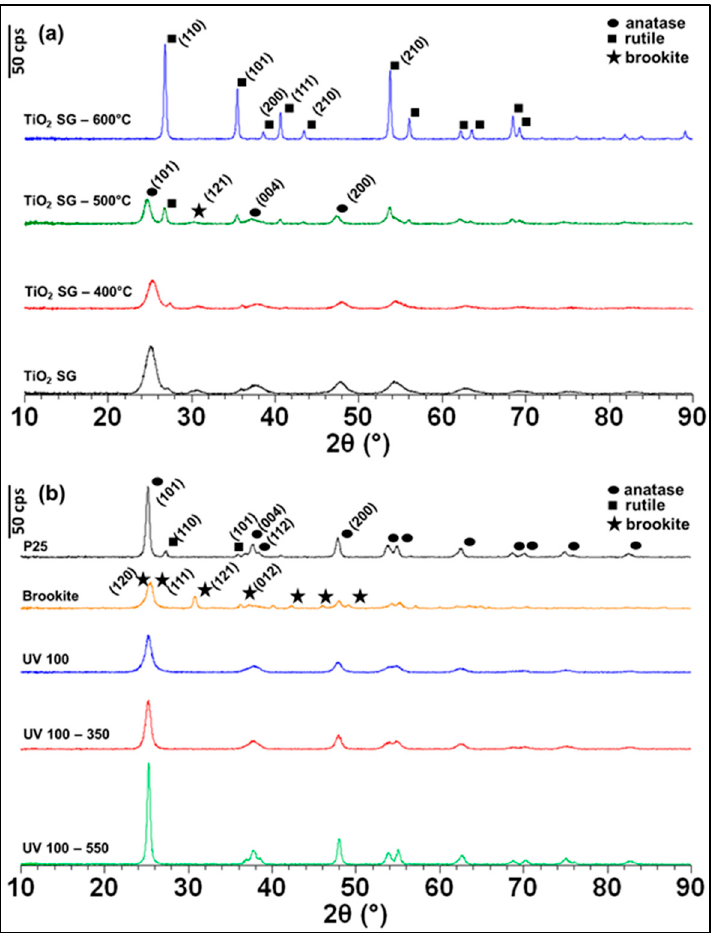
Figure 1. XRD pattern of ( a ) TiO 2 SG-X and ( b ) TiO 2 brookite and TiO 2 P25, and TiO 2 UV100-X commercial-based samples. Table 1. TiO 2 mean crystallite size, surface area, porosity measurements, band-gap value. Experi- mental error of a 10%, b 8%, and c 5%.